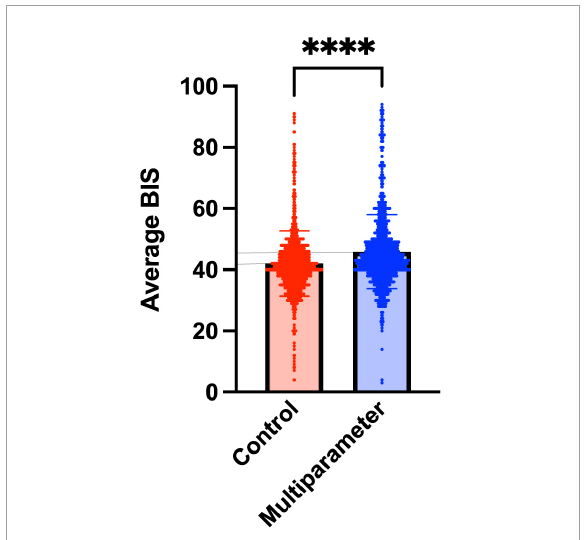
FIGURE2 A comparison of average BIS value among the groups. Average BIS index values throughout the intervention. Red is the control group, and blue is the BIS multiparameter group. The bar represents the mean with their standard deviation. ∗∗∗∗ p < 0.0001. BIS, bispectral